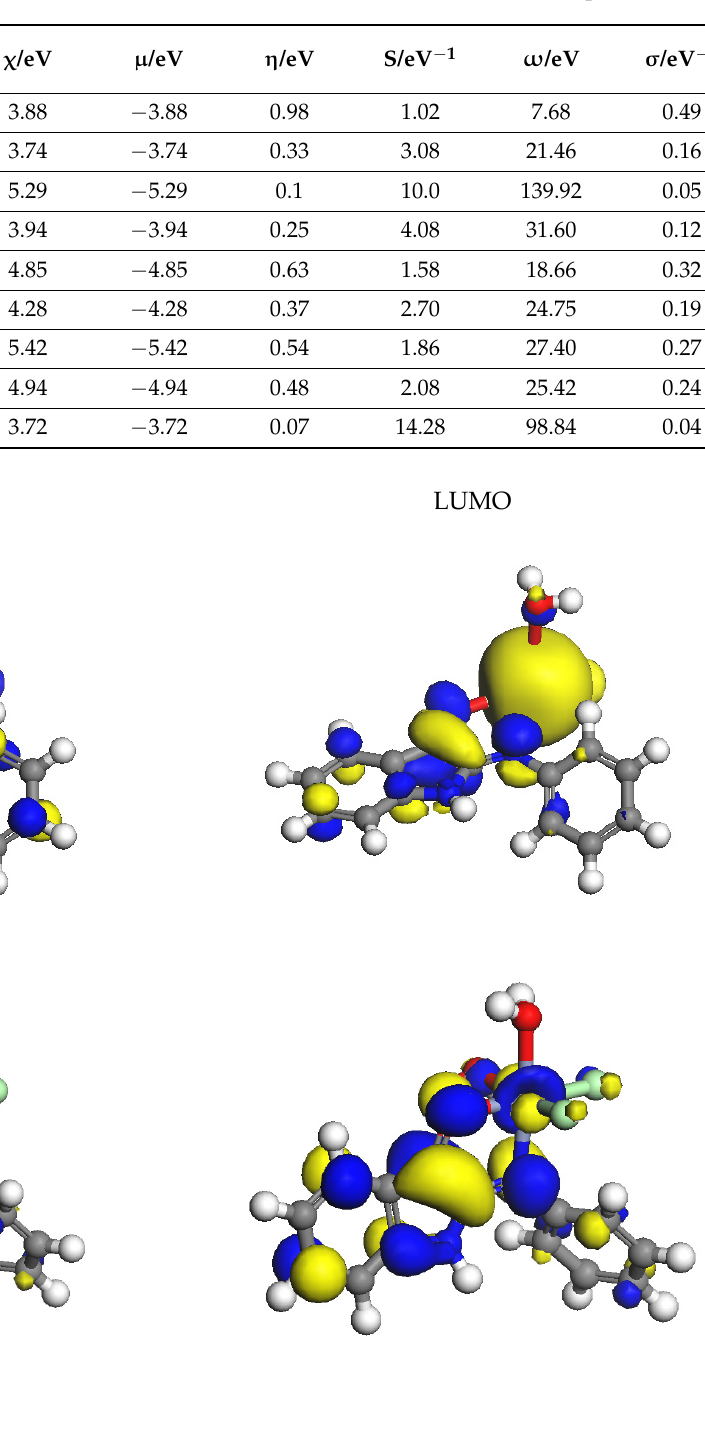
Table 4. Calculated EHOMO (EH), ELUMO (EL), energy band gap (E H –E L ), chemical potential ( µ